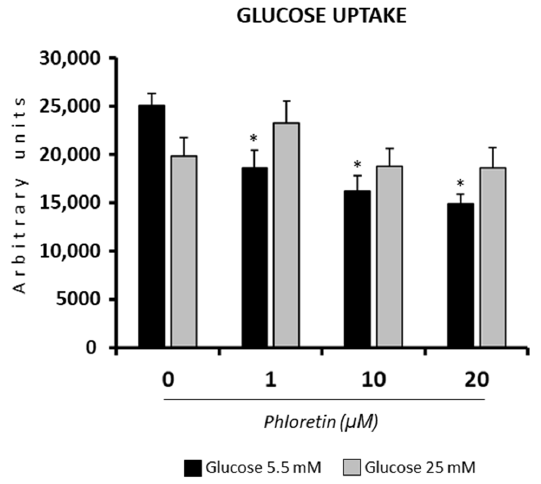
Figure 2. Effect of phloretin on glucose uptake, in MSC differentiated into adipocytes, at day 13 after differentiation started. The assay was performed on cells grown in a medium containing 5.5 or 25 mM of glucose. * p < 0.05 vs. cultures no treated (0 µM of phloretin).